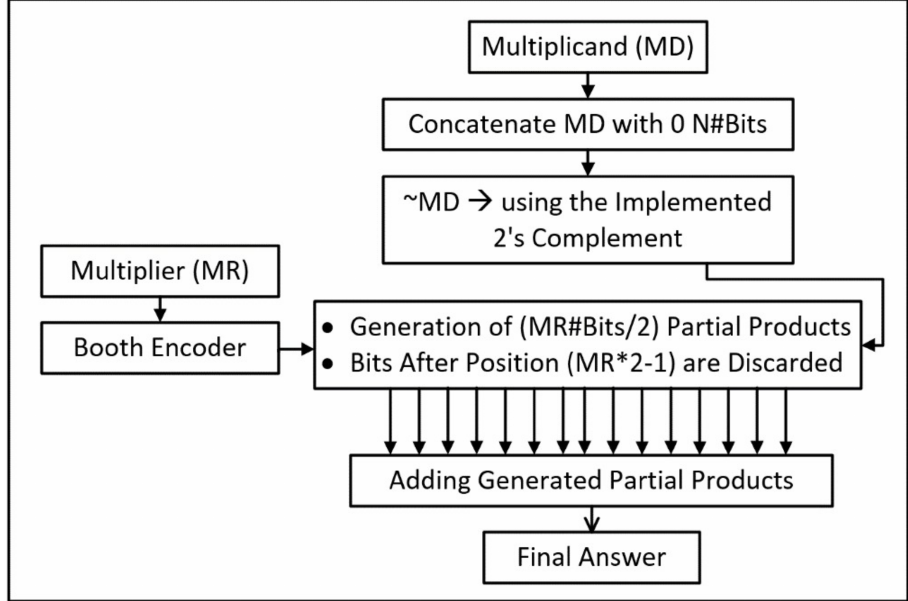
Figure 6. Proposed architecture for the Enhanced Radix-4 Modified Booth